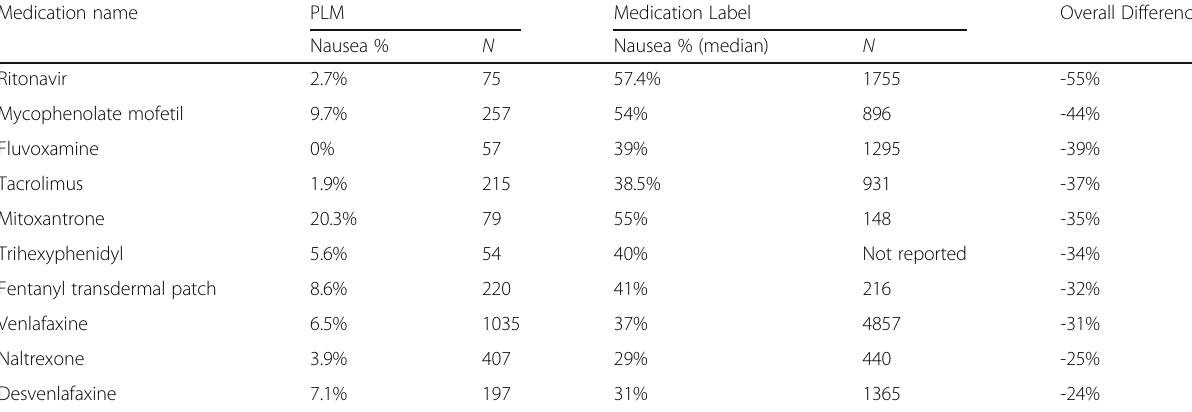
Table 1 Medications with largest absolute differences in nausea rates between PLM data and medication label